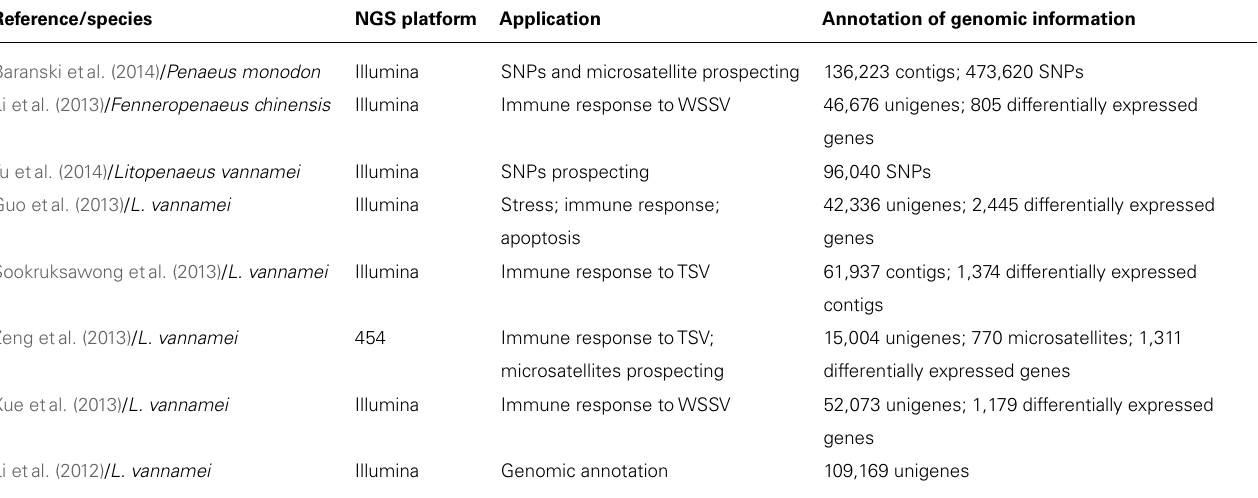
Table 1 | Summary of studies on penaeid shrimp using the RNA-seq approach.